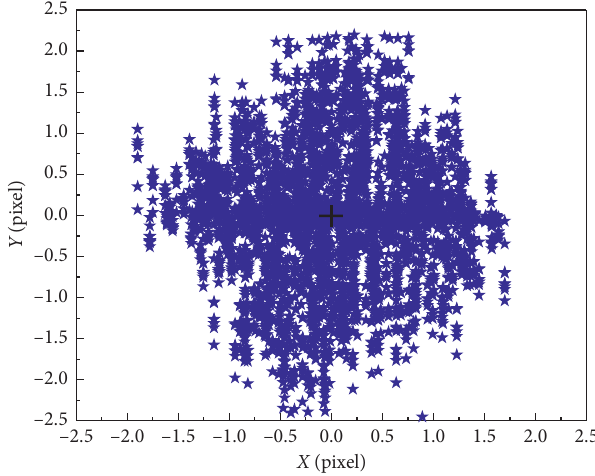
Figure 8: Spot position distribution at different